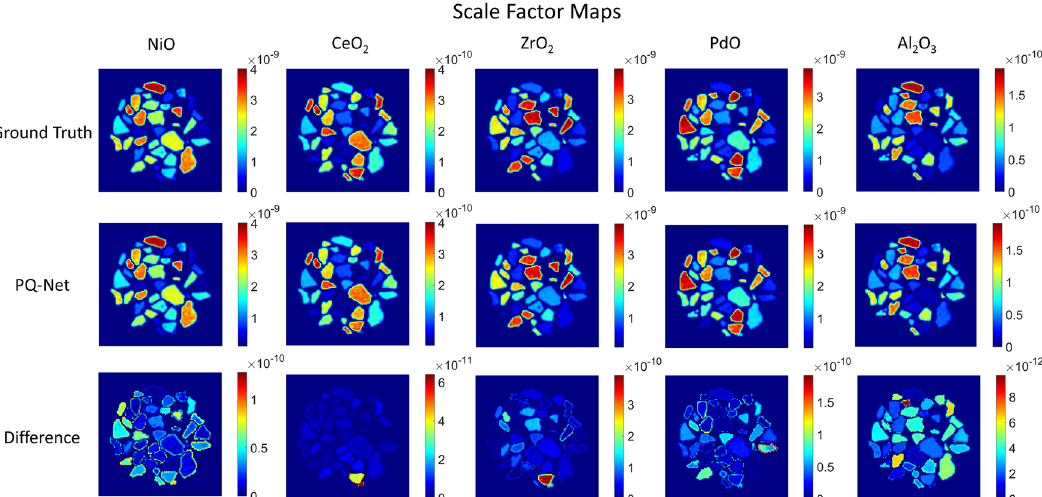
Fig. 3 PQ-Net scale factor results for the multi-phase simulated data. Scale factor ground truth maps, results obtained with the PQ-Net and their absolute difference for the simulated multi-phase NiO-PdO-CeO 2 -ZrO 2 -Al 2 O 3 system.